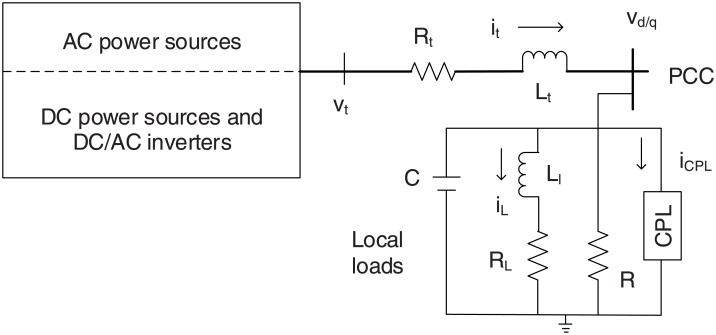
The schematic diagram of a microgrid [12, 13].